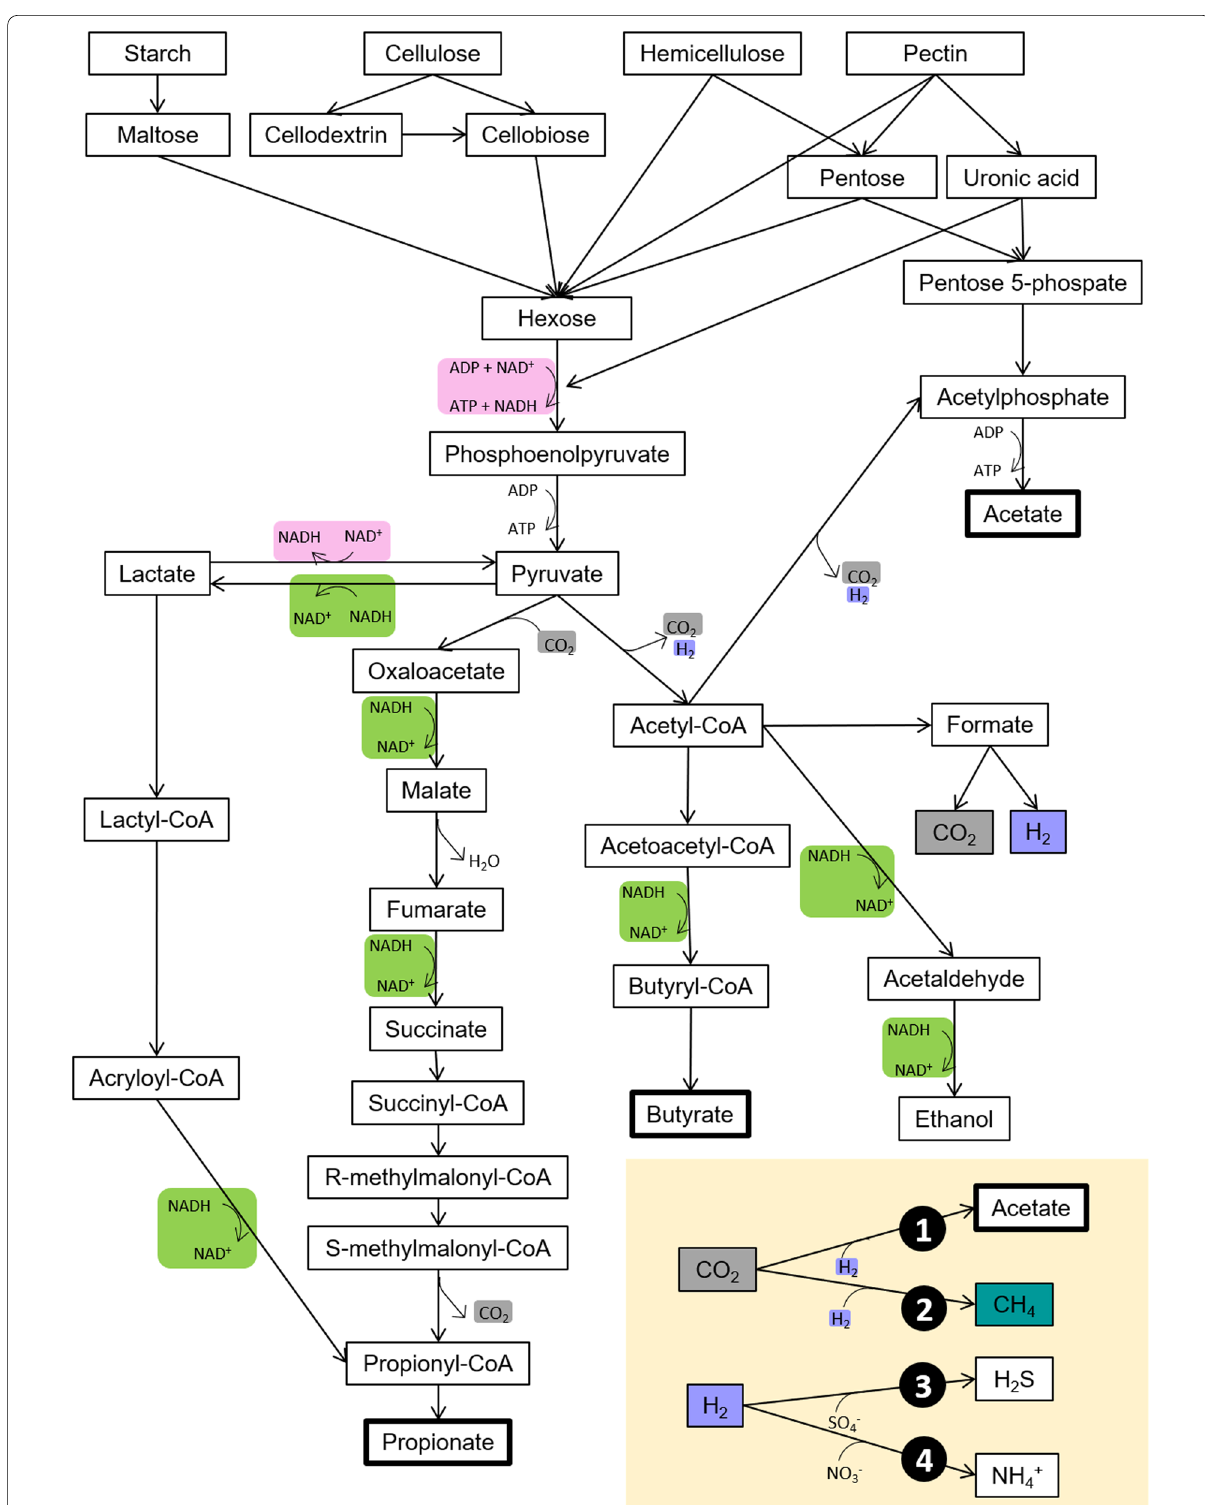
Fig. 2 Scheme of rumen carbohydrate fermentation pathways into volatile fatty acids (bold lined boxes) and other intermediate metabolites. The rumen H 2 sink pathways are displayed: reductive acetogenesis (1), methanogenesis (2), sulfate reducers (3), and nitrate reducers